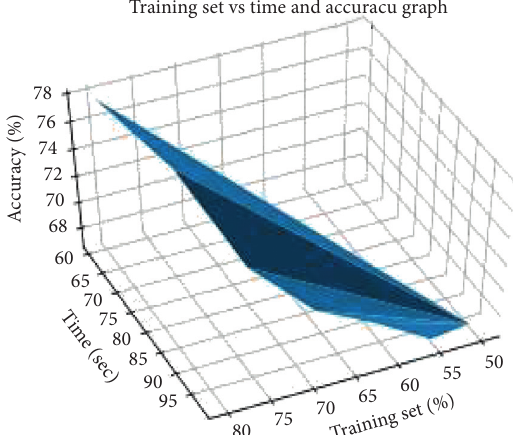
Figure 10: Recognition rates using a zoning-based feature set.